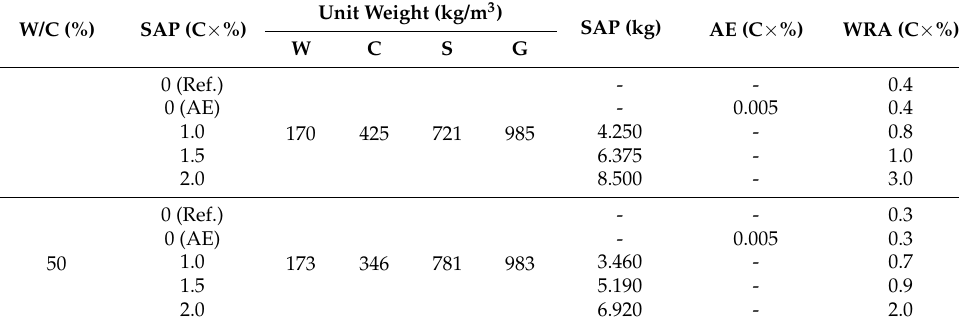
Table 2. Mix proportions of concrete.